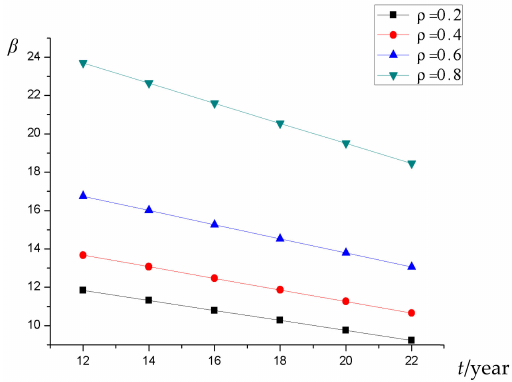
Figure 13. Non-probabilistic time-varying reliability index considering diameter and wall thickness.